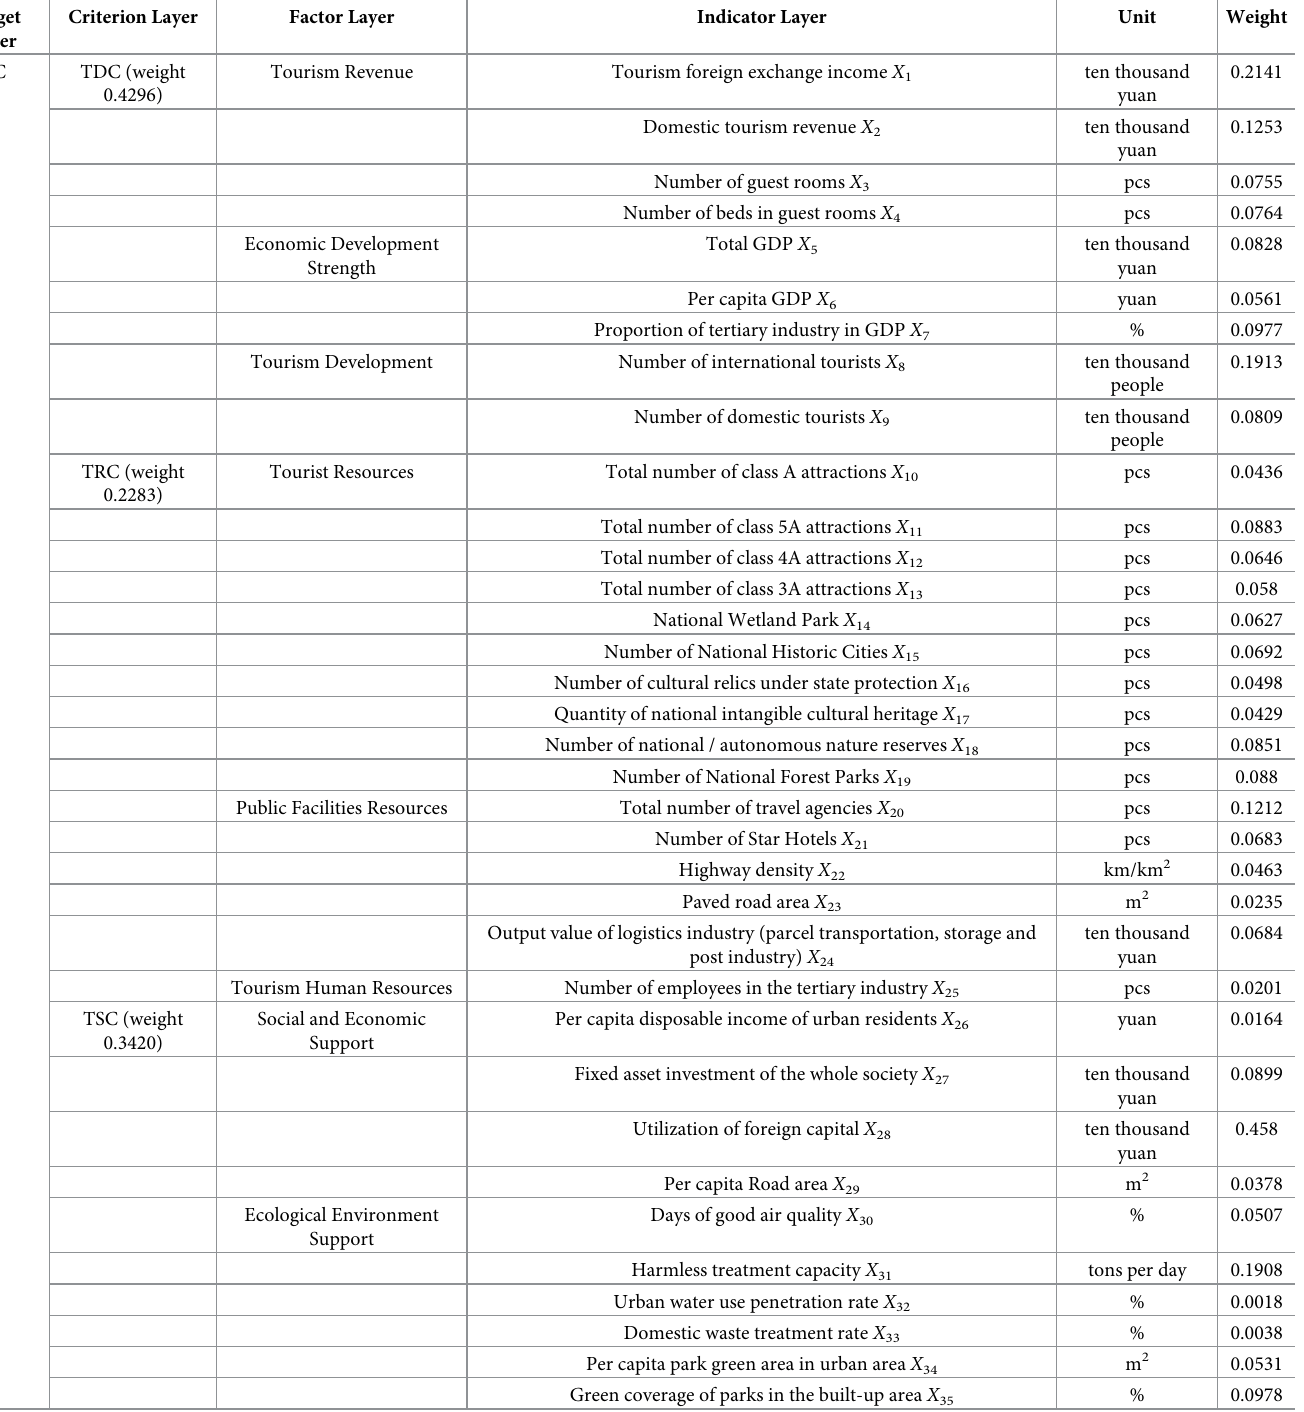
Table 1. Evaluation index system of tourism